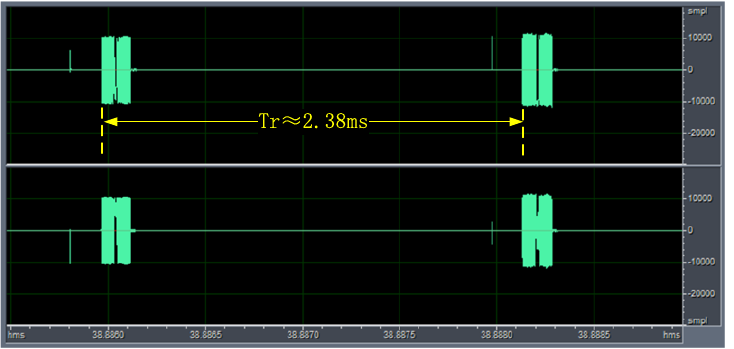
Figure 11. The collected IQ data of the reference channel with multiple pulse repetition periods after